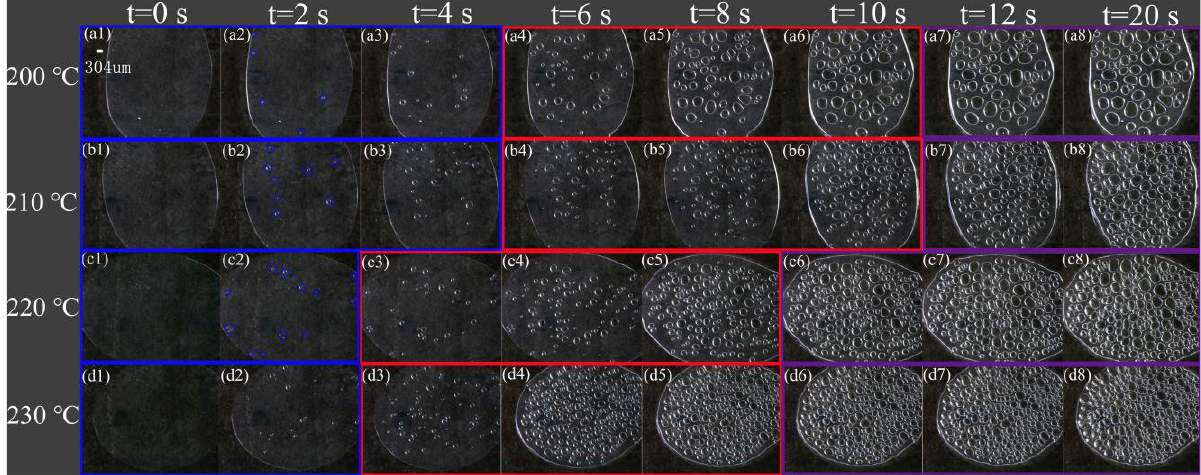
Figure 3. Video screenshots are at different times at different temperatures.